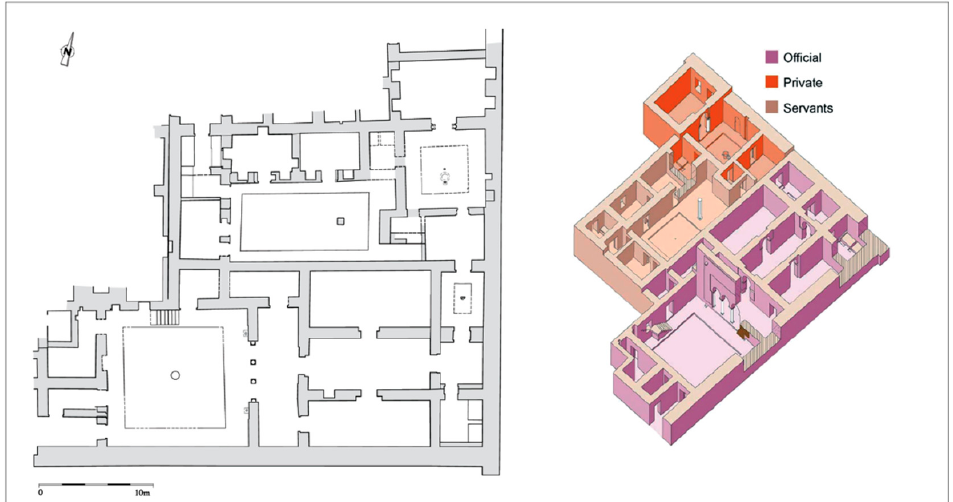
Figure 9. House of Ja c far. Plan (Vallejo Triano 2010, Figure 44).